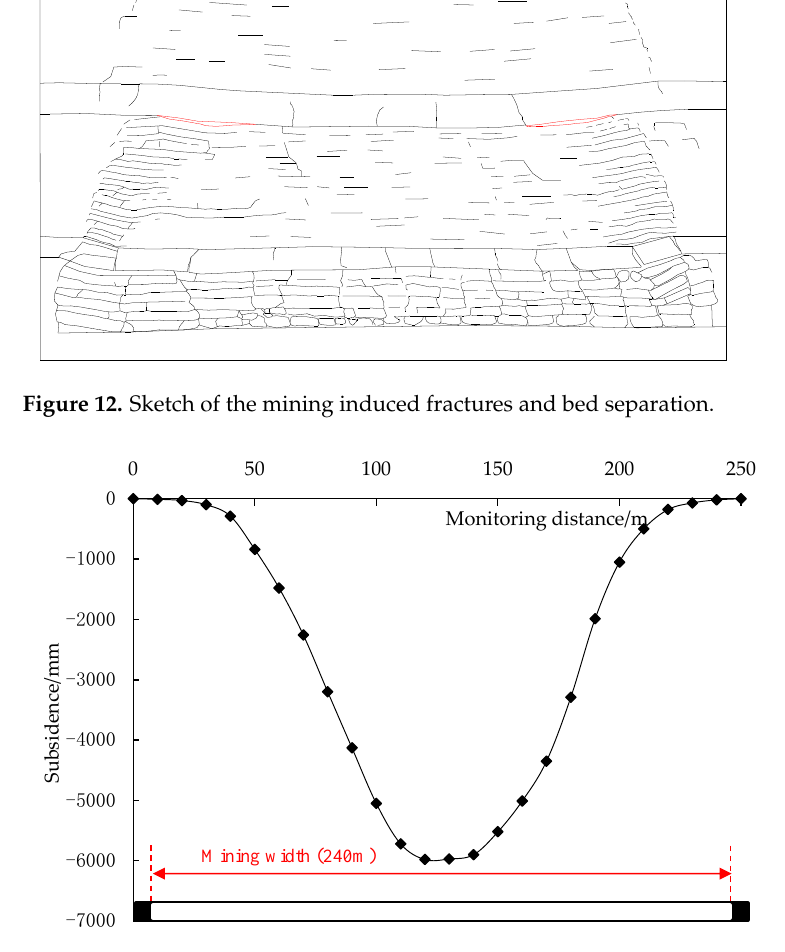
Figure 13. Surface subsidence caused by coal mining.